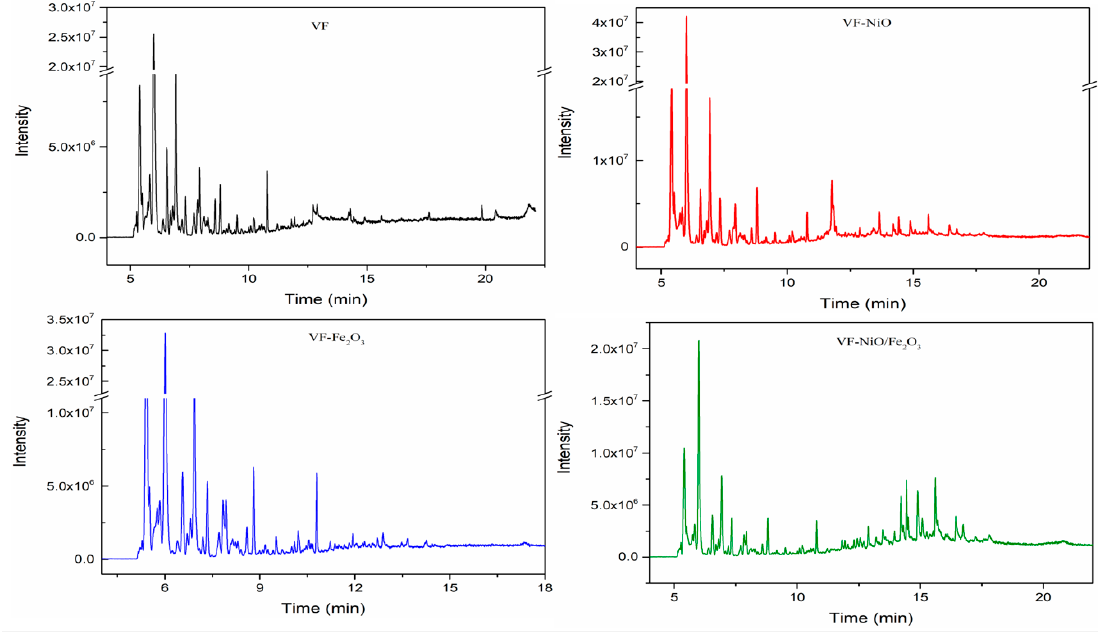
Figure 4. Total ion chromatograms of bio-oil vapor released from the fast pyrolysis of Vernicia fordii wood samples (VF, VF-NiO, VF-Fe 2 O 3 , and VF-NiO/Fe 2 O 3 ).